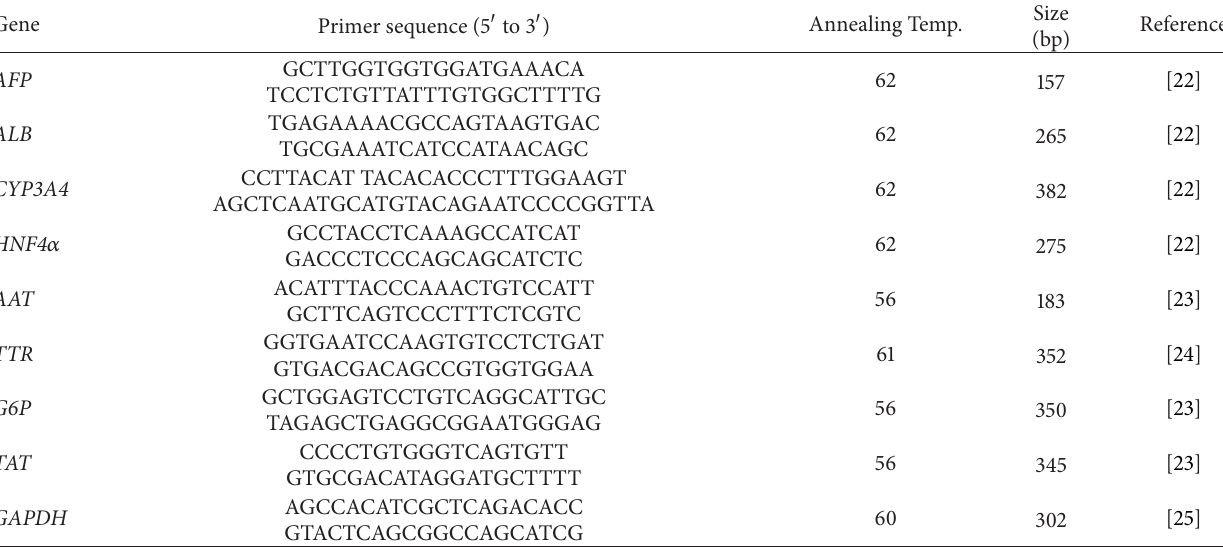
Figure 1: New method for hepatocyte-like cells generation from WJ-MSCs under hypoxic condition. This schematic figure represents two- step protocol for in vitro hepatogenic differentiation. In the first stage of induction, WJMSCs-SUT1 and WJMSCs-SUT2 were treated with the combination of HGF (20ng/mL) + FGF-4 (10ng/mL) + nicotinamide (5mM) in DMEM serum-free medium for 7 days. To induce maturation, these cells were cultured in differentiation medium containing OSM (40ng/mL) + ITS (20 𝜇 L/mL) + dexamethasone (2 𝜇 M) for a further 11 days. Table 1: List of primer sequences used in this